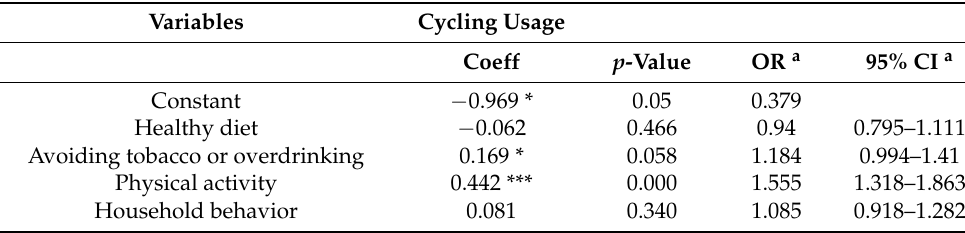
Table 5. Binary logistic regression